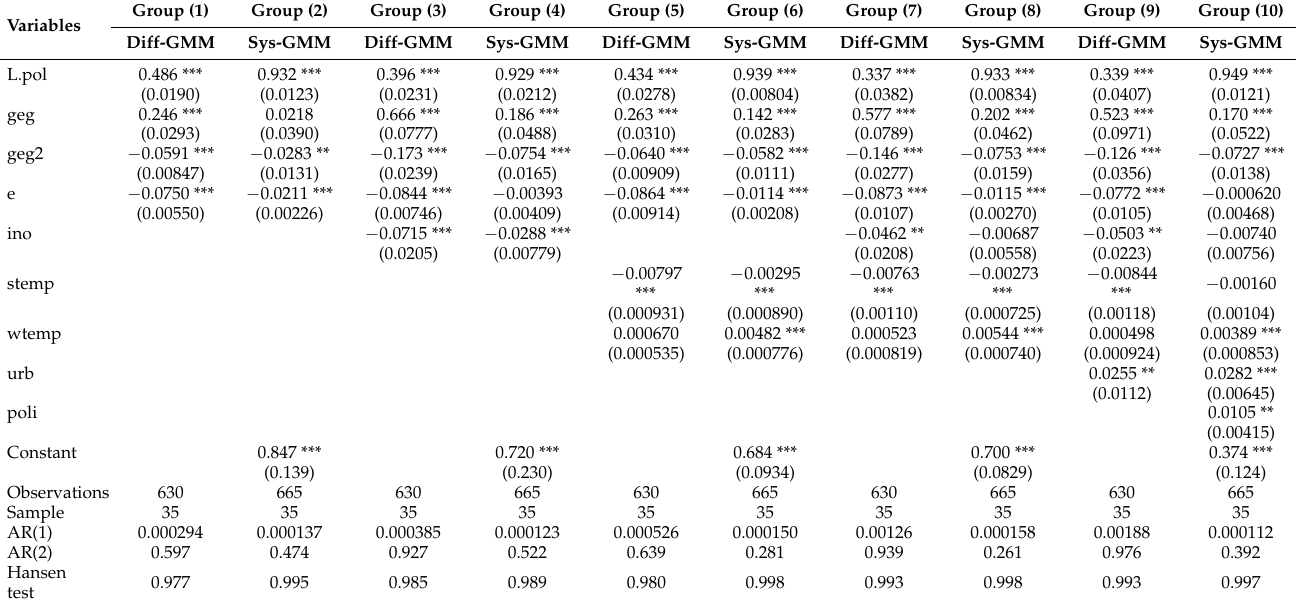
Table 8. The pollution function